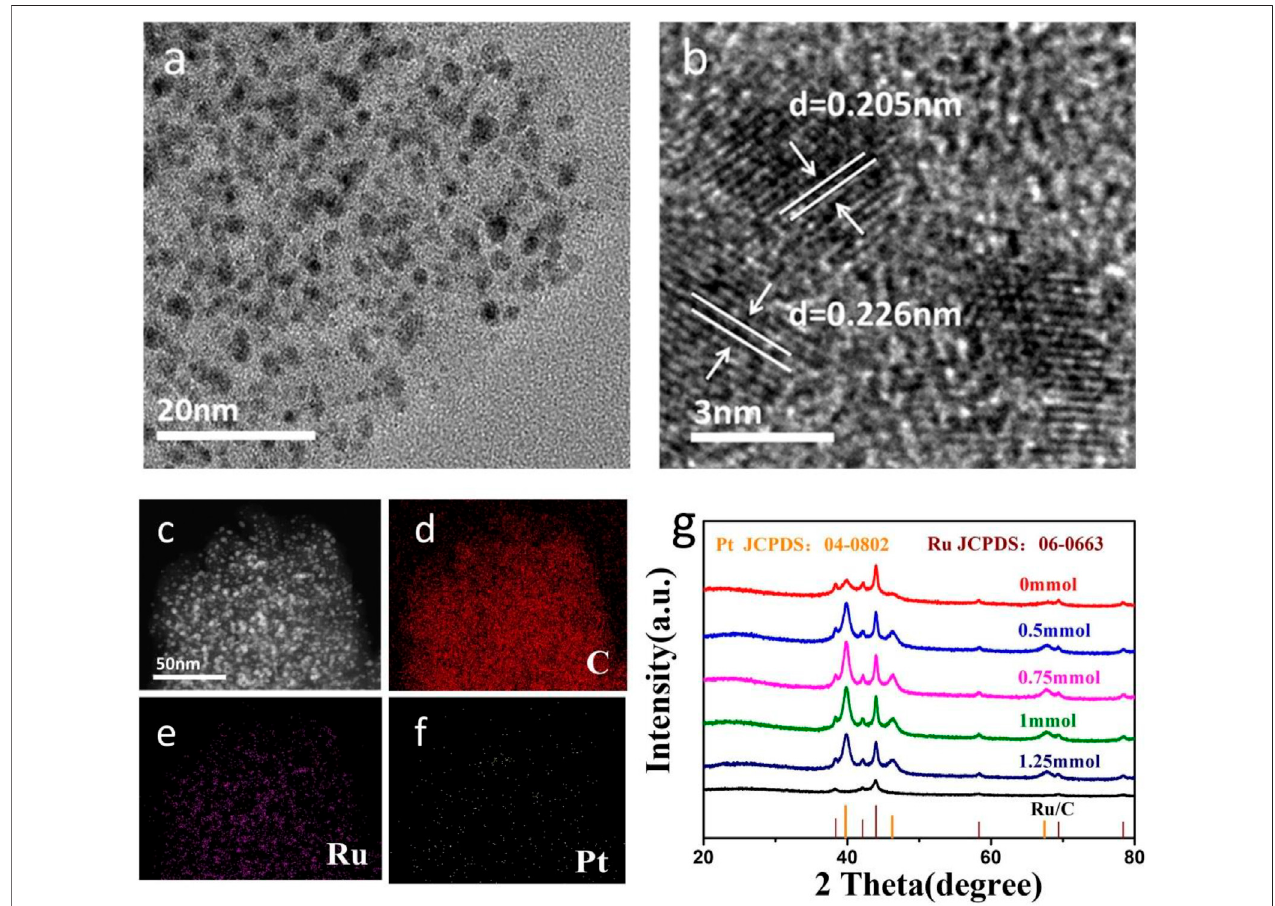
FIGURE2|(A) TEMimageofPtRu/C-0.75, (B) HRTEMimageofPtRu/C-0.75, (C) STEMimageofPtRu/C-0.75andthecorrespondingEDXelementalmappingof (D) C, (E) Ru and (F) Pt, (G) X-ray diffraction (XRD) patterns of PtRu/C at different NaOH